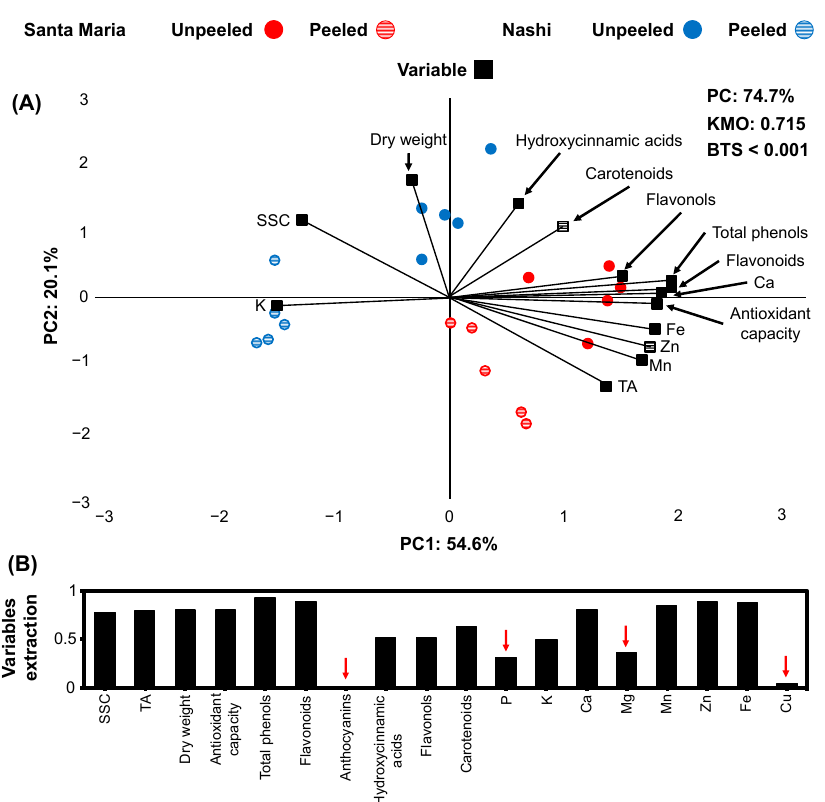
Figure 2. Principal component analysis (PCA) in a biplot ( A ) of physio-biochemical attributes and nutrients content (variables = black) of two pear cultivars (Santa Maria: red, Nashi: blue) unpeeled (circle filled with color) compared to peeled (circle filled with horizontal lines) after 2 months of cold storage. Eighteen physio-biochemical and mineral variables extraction ( B ) based on the representation in the PCA model (red arrows indicate variables with low representation in the PCA model).